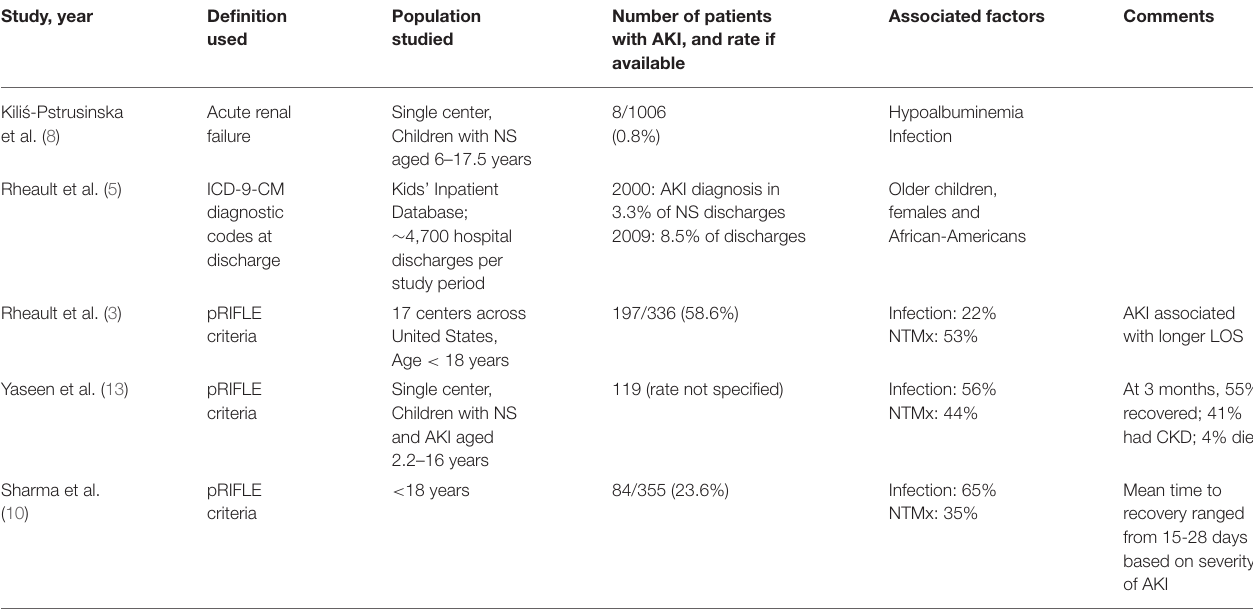
TABLE 1 | Summary of recent epidemiological studies in children with Nephrotic Syndrome and Acute Kidney Injury. Study,